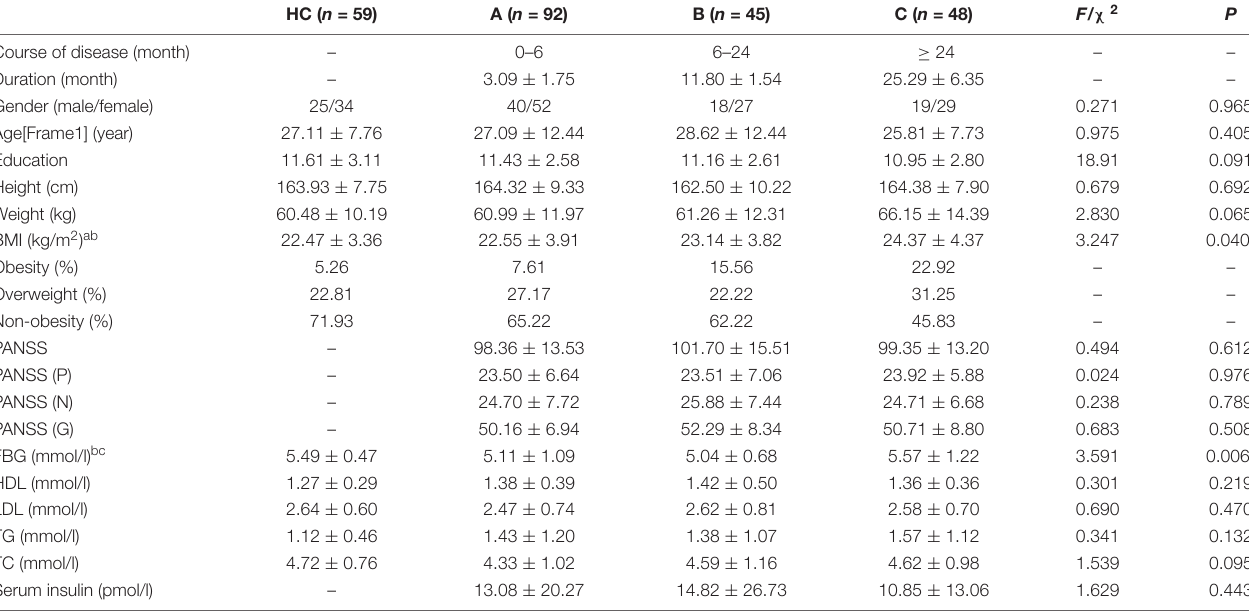
TABLE 1 | Comparison of demographic characteristics and metabolic indexes.